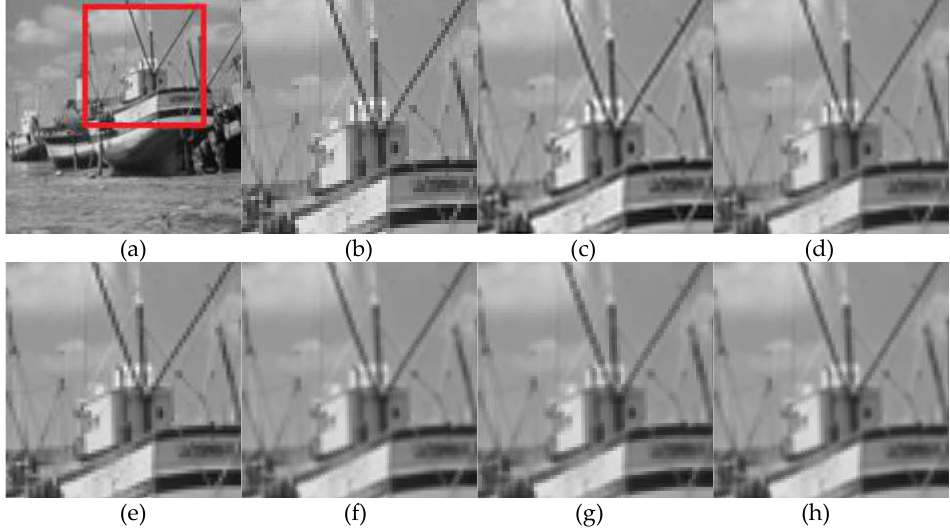
Figure 13. (a) Boat test image inside a red square: (b) traditional nearest neighbor (TN), (c) 375 Figure 13. ( a ) Boat test image inside a red square: ( b ) traditional nearest neighbor (TN), ( c ) traditional